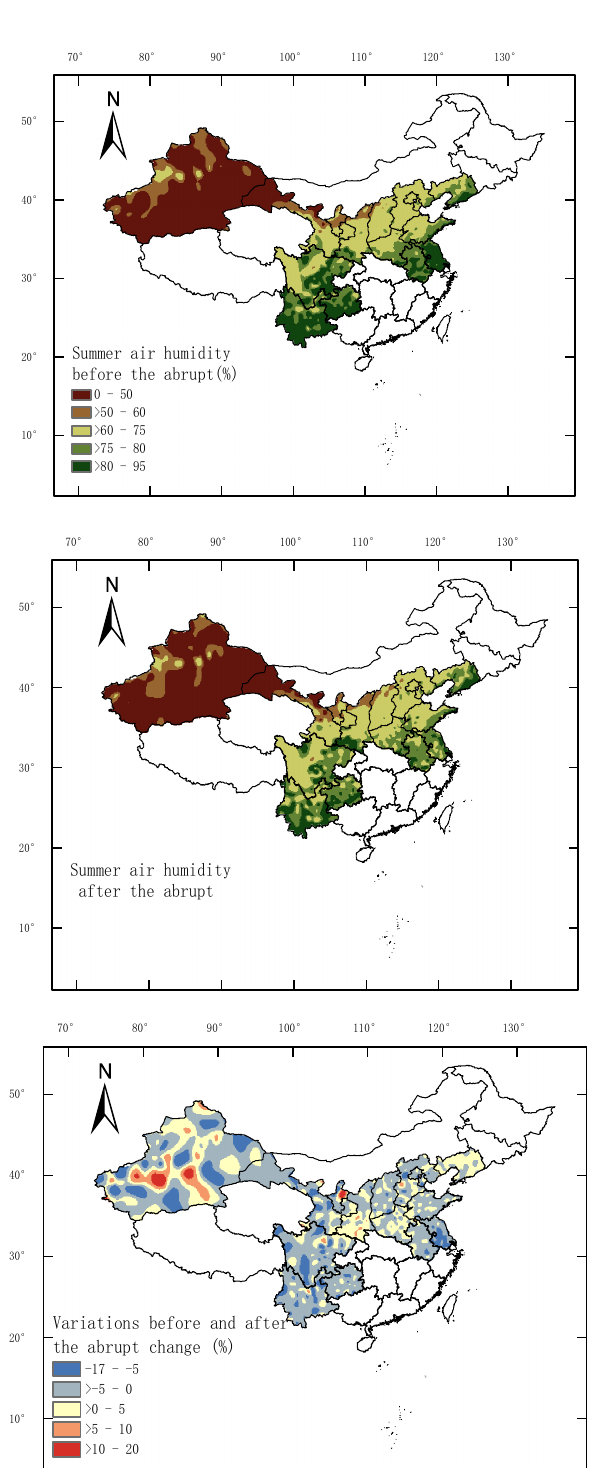
Figure 8. The changes in spatial distribution of the major apple-producing regions in China before and after the abrupt change of average relative humidity, wherein the yellow area represents the optimal range of average relative humidity for high-quality apple growing.